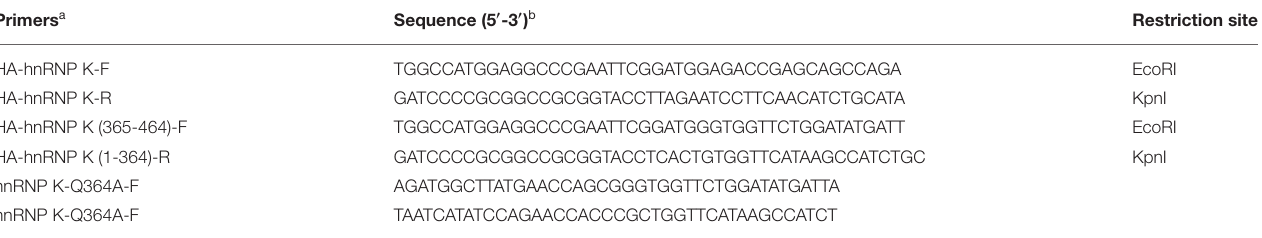
TABLE 1 | Primers used in this study. Primers a Sequence (5 ′ -3 ′ )